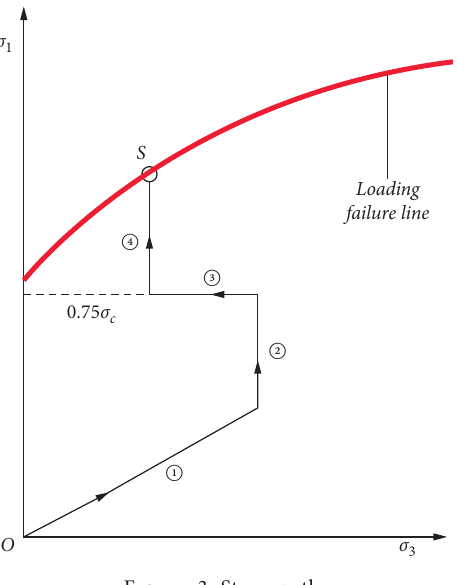
Figure 3: Stress